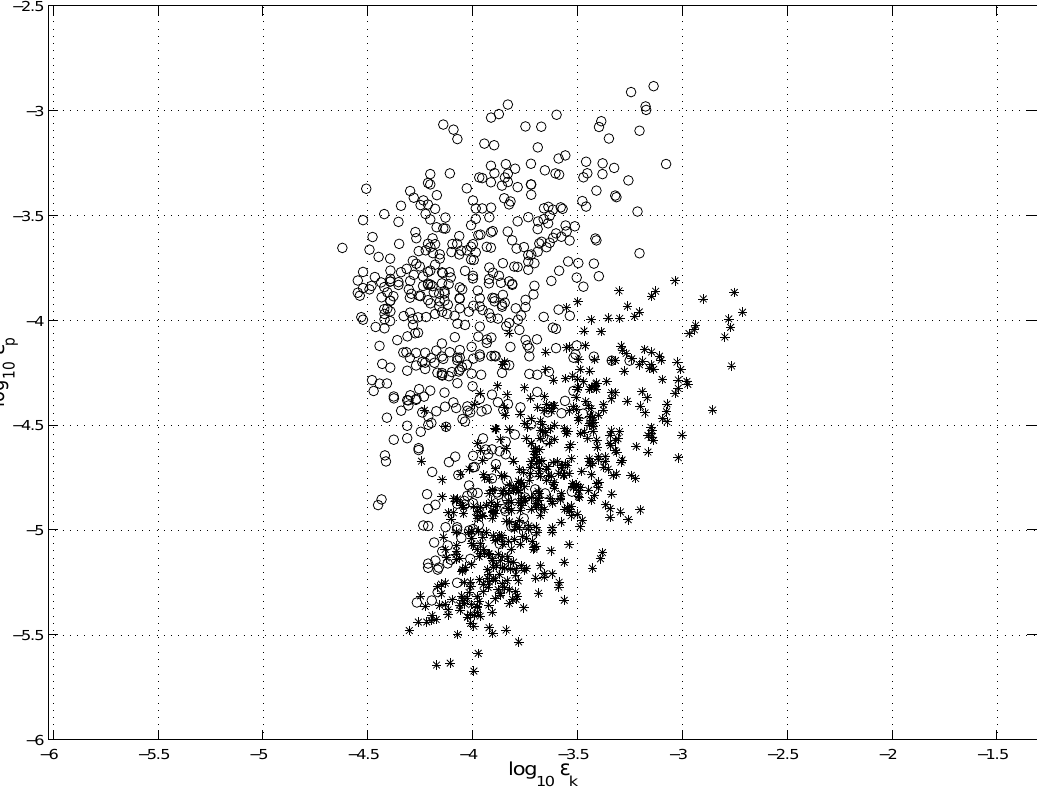
Fig. 4. Scatter plot of (cid:15) k versus (cid:15) p in case of weak stability (circles) and high stability